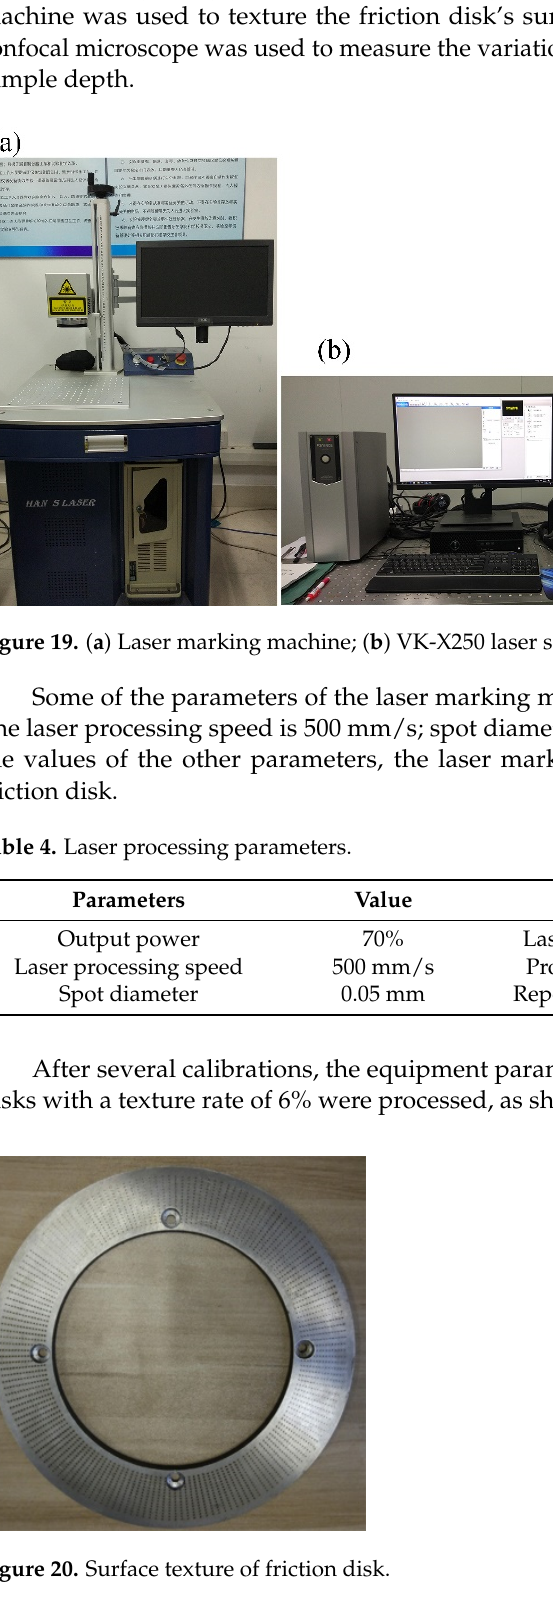
Figure 18. Mass-transfer rate of air at different times in a single cylindrical textured dimple.